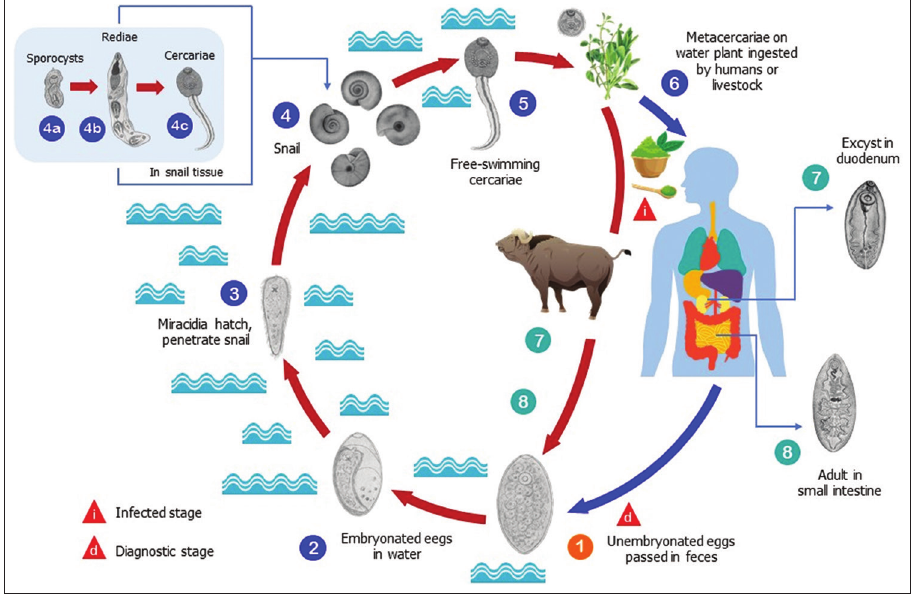
Figure-2: Life cycle of Fasciolopsis buski (modified CDC, pictures were extracted from Koan Nakagawa and freepik.com)